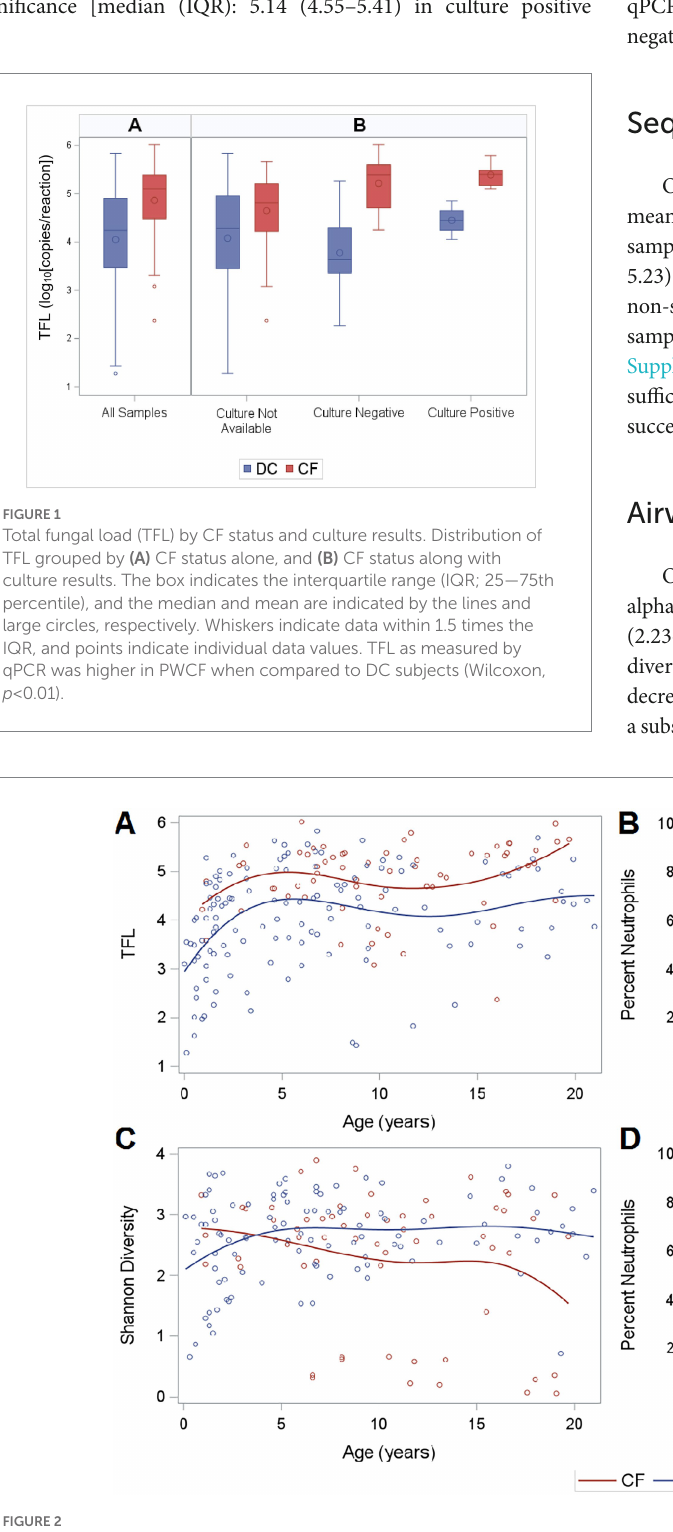
FIGURE 2 Fungal load, diversity, and neutrophilic inflammation. (A) TFL across age, (B) Neutrophilic Inflammation across TFL, (C) Shannon Diversity across age, and (D) Neutrophilic Inflammation across Shannon Diversity. Curves are generated using a cubic B spline scatterplot